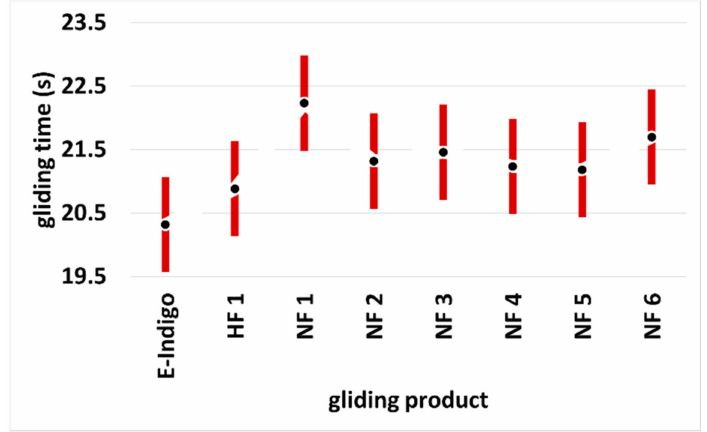
Figure 6. Running times over a measuring section for different ski gliding layers. Tests with calibrated cross-country skis (Lenzerheide, Switzerland, October 2020). The data points show the mean values with the 95% scatter bars. Snow temperature: − 8 ◦ C; air humidity: 75%; dry, old snow, grain size 0.5–0.8 mm, star-shaped grains, no dirt (HF: high fluor wax; NF: non-fluorinated wax)